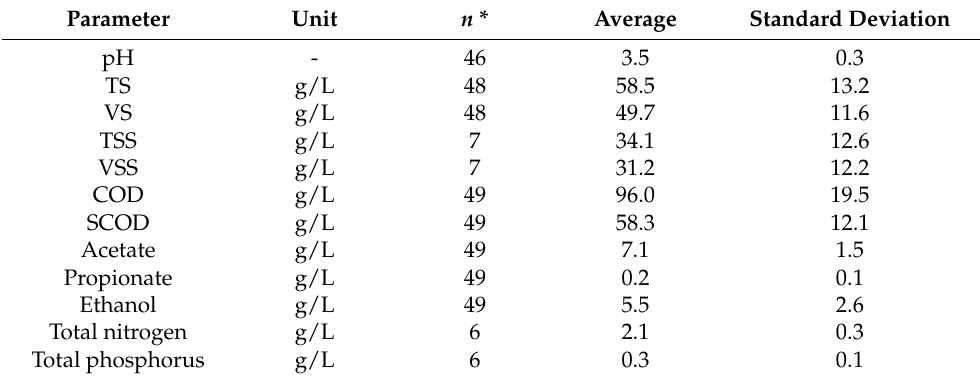
Figure 1. The schematic of the demo-scale anaerobic digester. Black arrows indicate the flow regime. Table 1. The characteristics of the substrate monitored throughout the experiment.